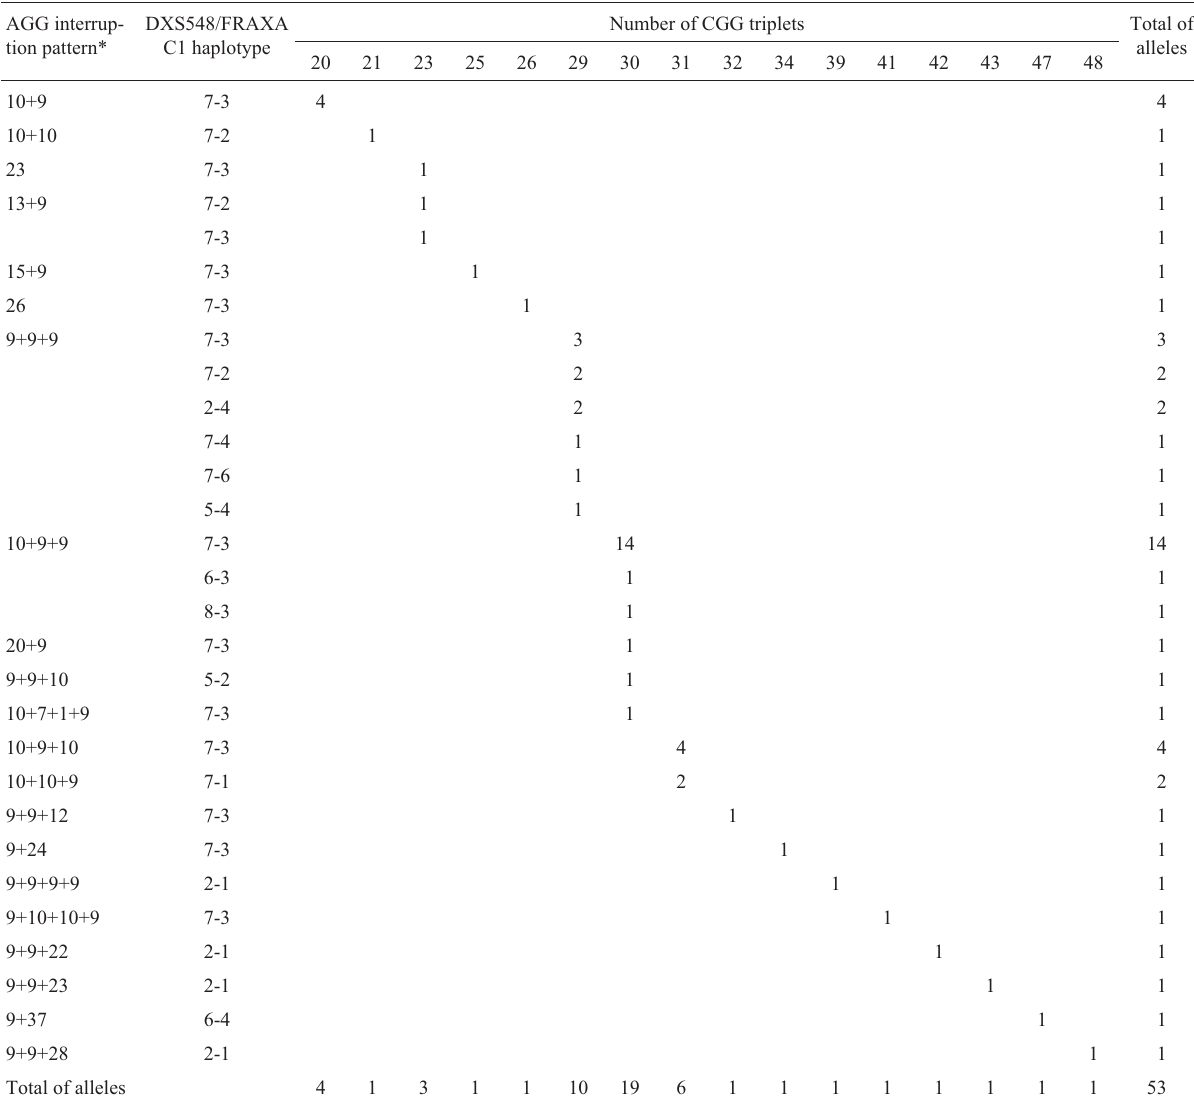
Table 2 - Distribution of 53 FMR1 common and intermediate alleles, according to the length of the repeat, AGG interspersion patterns, and linked DXS542/FRAXAC1 haplotypes. AGG interrup- tion